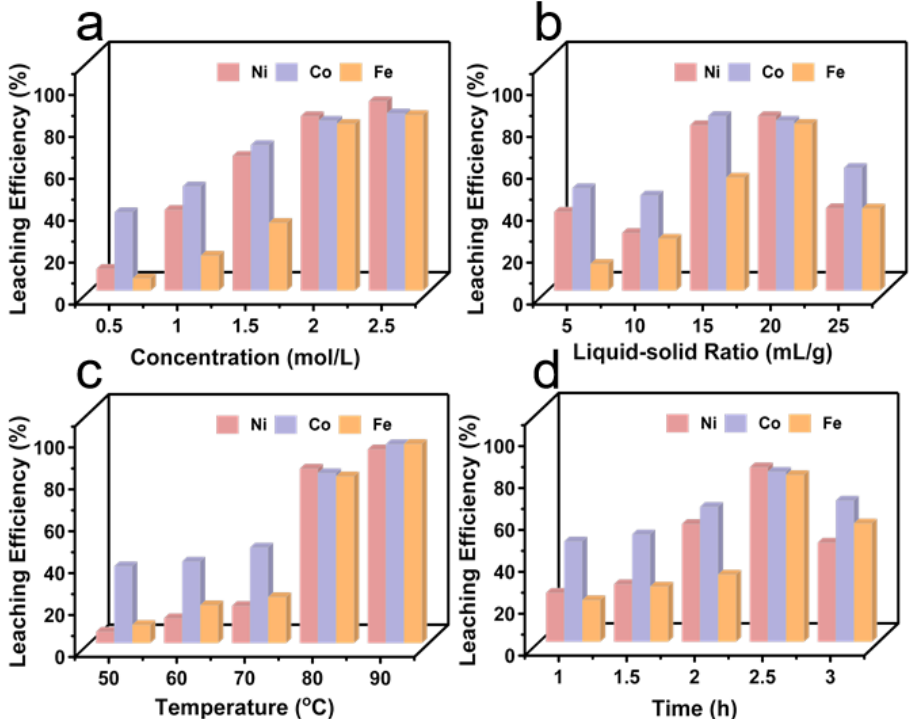
Figure 4. Effect of acid leaching conditions on leaching efficiency of nickel, cobalt and iron. ( a ) sul‑ furic acid concentration, ( b ) liquid‑solid ratio, ( c ) temperature, ( d ) time.